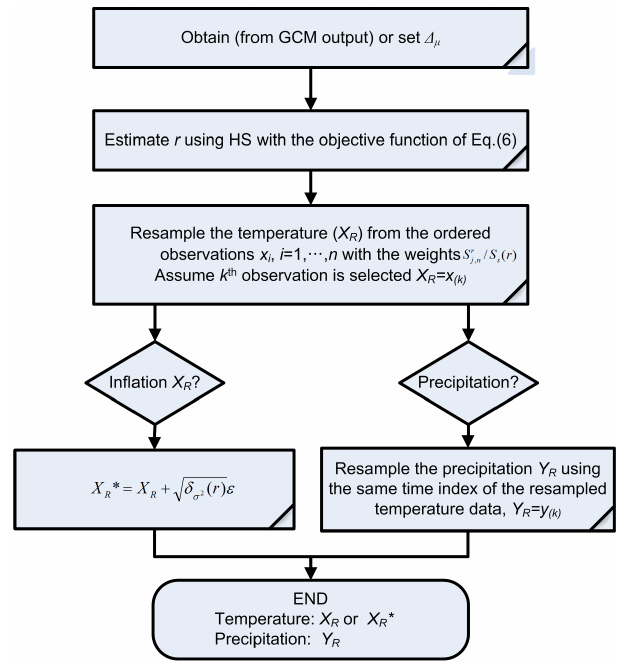
Figure 1. Procedure for the proposed simulation IBB method of temperature and precipitation